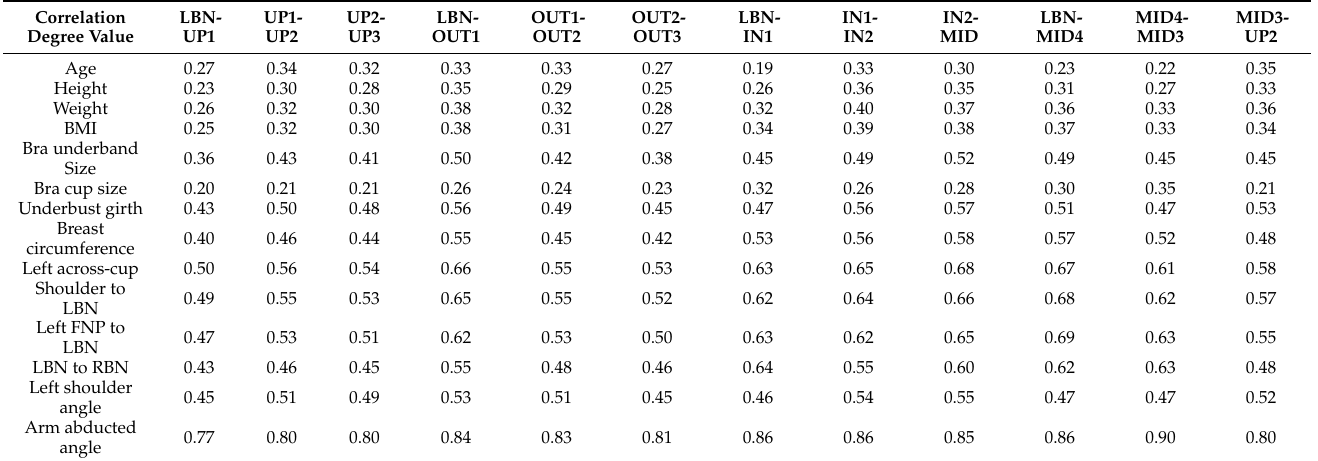
Table 3. The correlation grade among 14 body parameters and the 12 breast displacements.